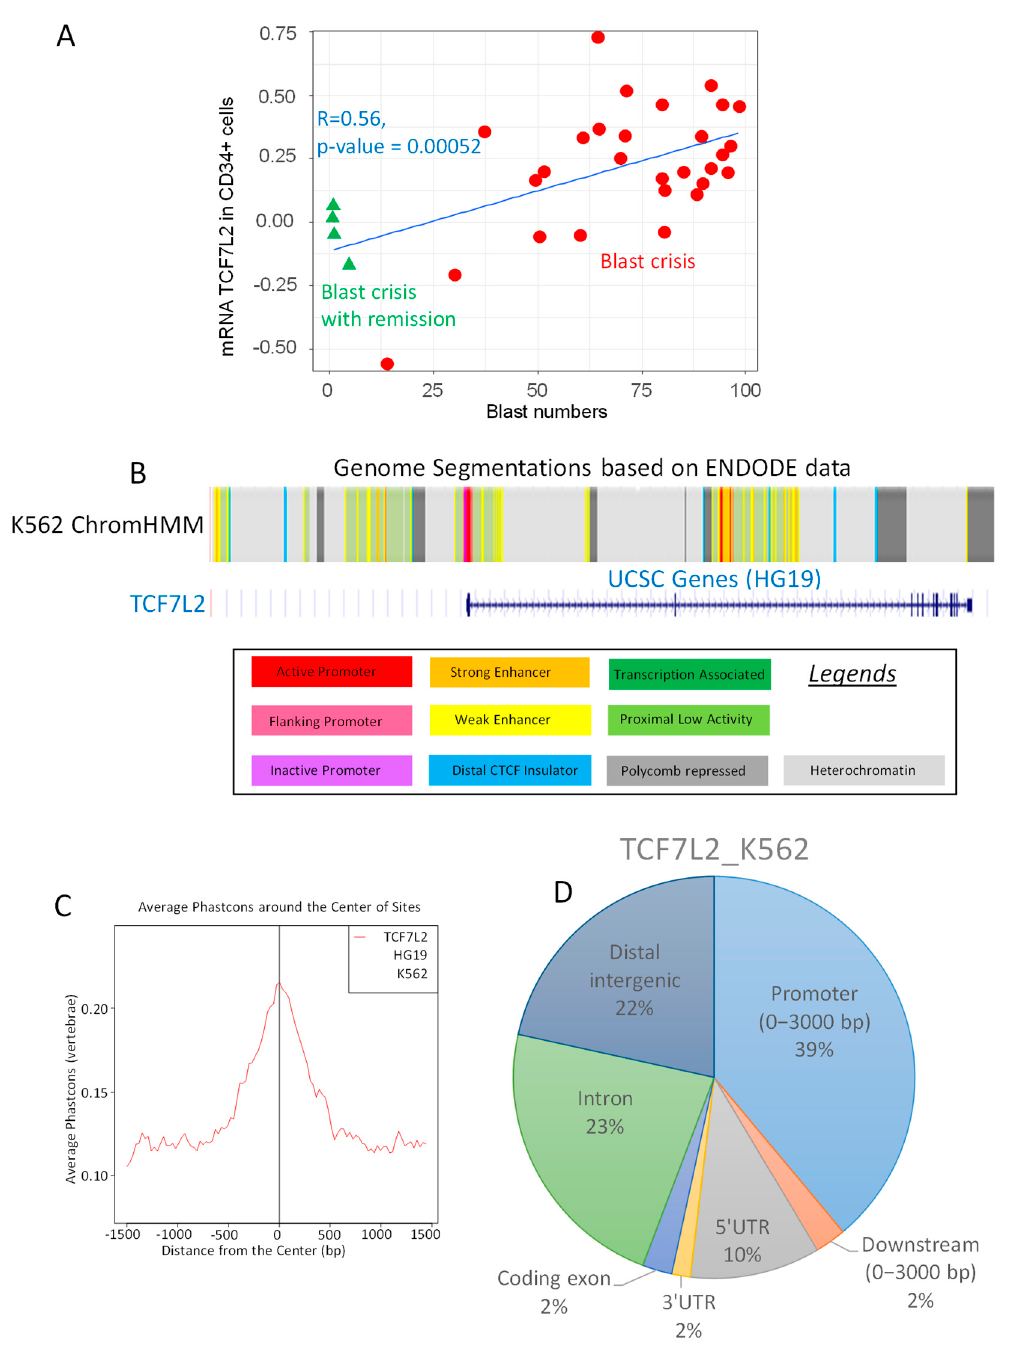
Figure 1. Regulation of TCF7L2 expression during CML blast crisis. ( A ) Scatterplot of TCF7L2 expression in CD34 + cells from patients in CML Blast Crisis versus the number of circulating blasts: red circles represent patients in blast crisis and green triangles represent patients in blast crisis with remission, linear model is presented as blue lines and results of the two-sided Pearson Correlation test is written in blue; ( B ) Functional Genomic Hidden Markov Model covering eight histone marks and CTCF chromatin binding for the activity of the TCF7L2 promoter in the K562 cell line; ( C ) Phast-conservation plot around Centers of the Sites for TCF7L2 chromatin binding by CHIP-sequencing (ENCODE data) in K562 normalized on vertebrae promoter database; ( D ) Pie chart of peak proportion in genomic regions concerning TCF7L2 chromatin binding in K562 cells and normalized on the HG19 version of the human genome .